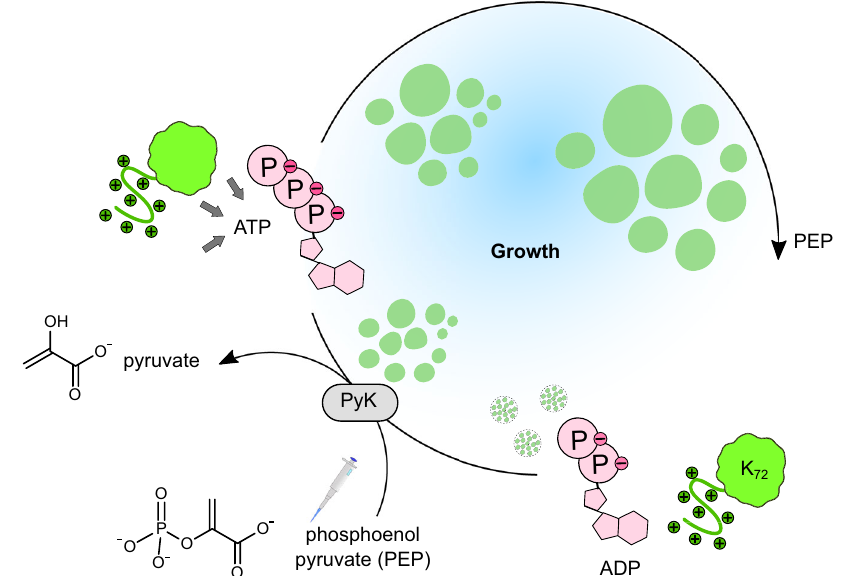
Fig. 1 Active droplets scheme. The pyruvate kinase-catalyzed (PyK) conversion of ADP to ATP, combined with the liquid – liquid phase separation of ATP- K 72 complexes, is a minimal translation of an active droplet. In this system, ADP is the substrate, and ATP (together with the lysine-rich protein K 72 ) is the droplet material. We fuel the droplets by manual addition of the second substrate, PEP. The waste, pyruvate, is not re-used in our setup. The local increase in the amount of ATP inside the droplets causes the recruitment of more protein, leading to droplet growth. Growth may compete with other active (nucleation) and passive (coalescence, Ostwald ripening) processes that need to be distinguished experimentally.